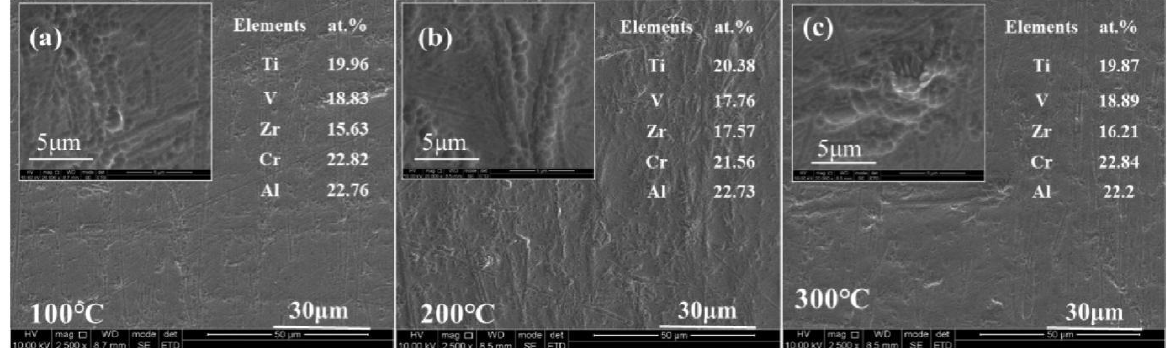
Figure 6. SEM images and elemental compositions of the TiVZrCrAl coatings’ surface at different deposition temperatures [ 57 ] : ( a ) 100 °C, ( b ) 200 °C, ( c ) 300 °C. Copyright 2022 Elsevier. deposition temperatures [57]: ( a ) 100 ◦ C, ( b ) 200 ◦ C, ( c ) 300 ◦ C. Copyright 2022